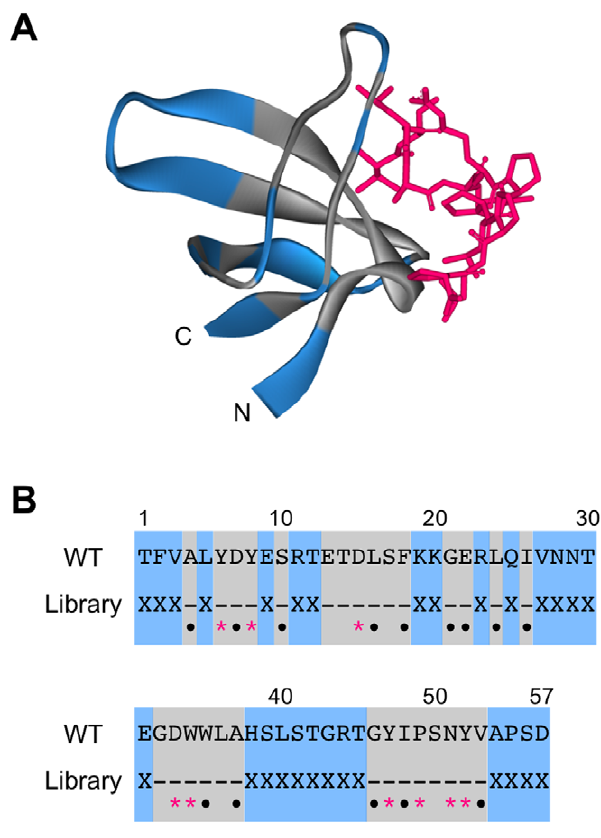
Figure 2. The three-dimensional structure and sequence of the src SH3 domain. (A) The three-dimensional structure of the complex of the SH3 domain with the VSL12 peptide. The randomized and conserved positions of the SH3 domain in this study are shown in blue and gray, respectively. The peptide ligand VSL12 is shown in red. Structure was visualized by Accelrys DiscoveryStudio 2.1 (PDBid: 1QWF, [21]). (B) The amino-acid sequence of the SH3 domain. The randomized amino acids (X) are shown in blue. In the highly conserved region (gray), red asterisks indicate residues contacting the peptide ligand and black dots indicate residues that are important in determing the domain structure [8], [16].